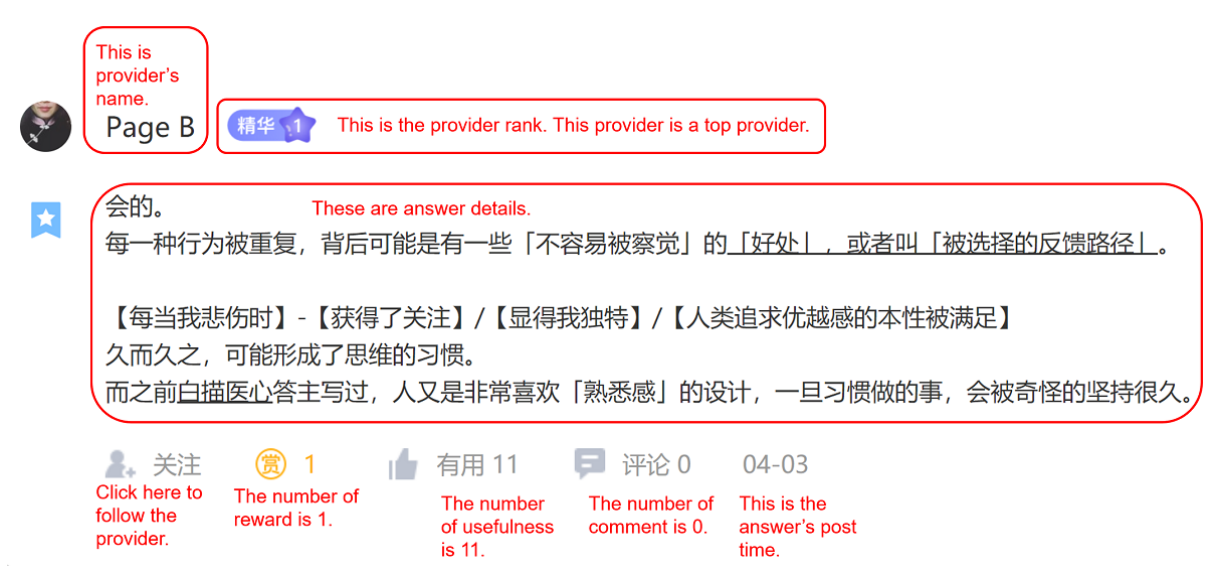
Figure 3. A sample of an